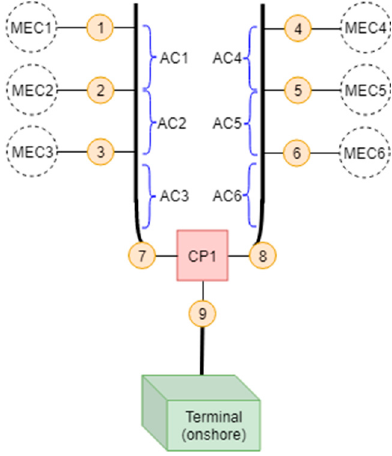
Figure 5. Sketch of energy transfer network topology.